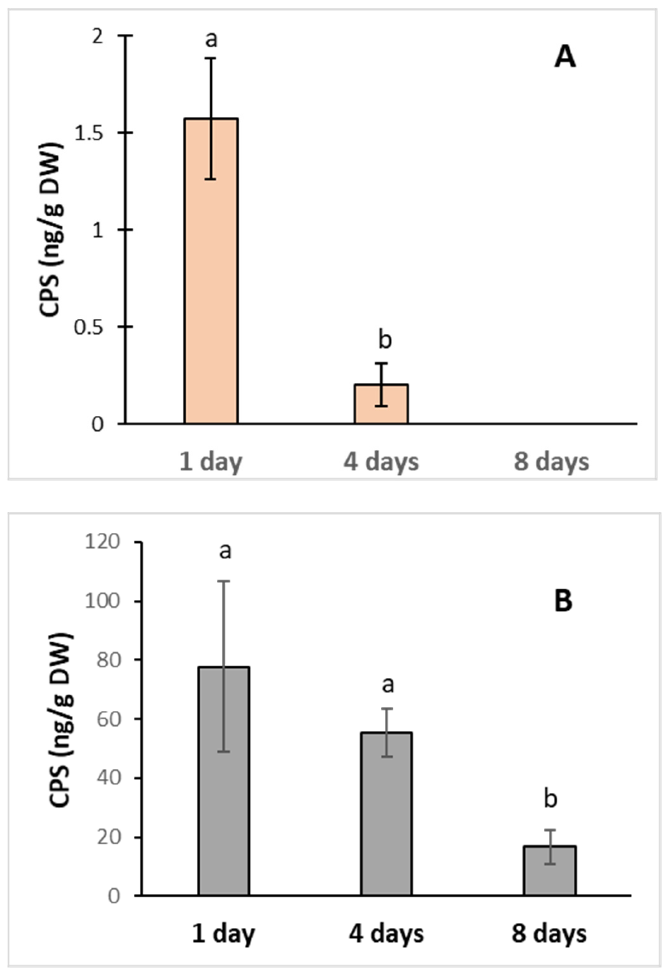
Figure 1. CPS content in poplar cells growing in medium supplemented with CPS at initial concen- trations ( A )—0.1 mg L − 1 ; ( B )—1 mg L − 1 . The samples were collected after 1, 4, and 8 days of cultiva- tion. The data represent the mean ± S.D. ( n = 4). Different letters mean statistically significant differ- ences (p ≤ 0.05).